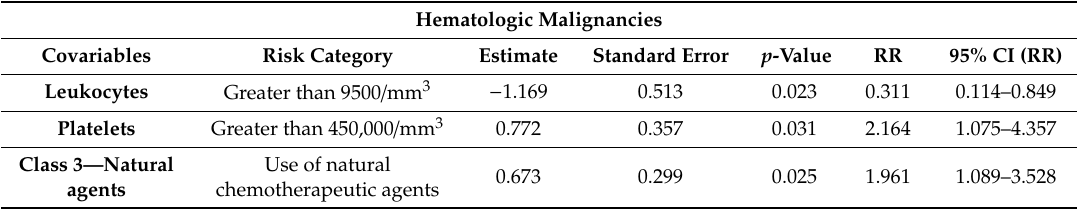
Table 2. Estimated parameters and relative risk (RR) corresponding to the final model for patients with hematologic malignancies treated at Napole ã o Laureano Hospital, 2013–2017.